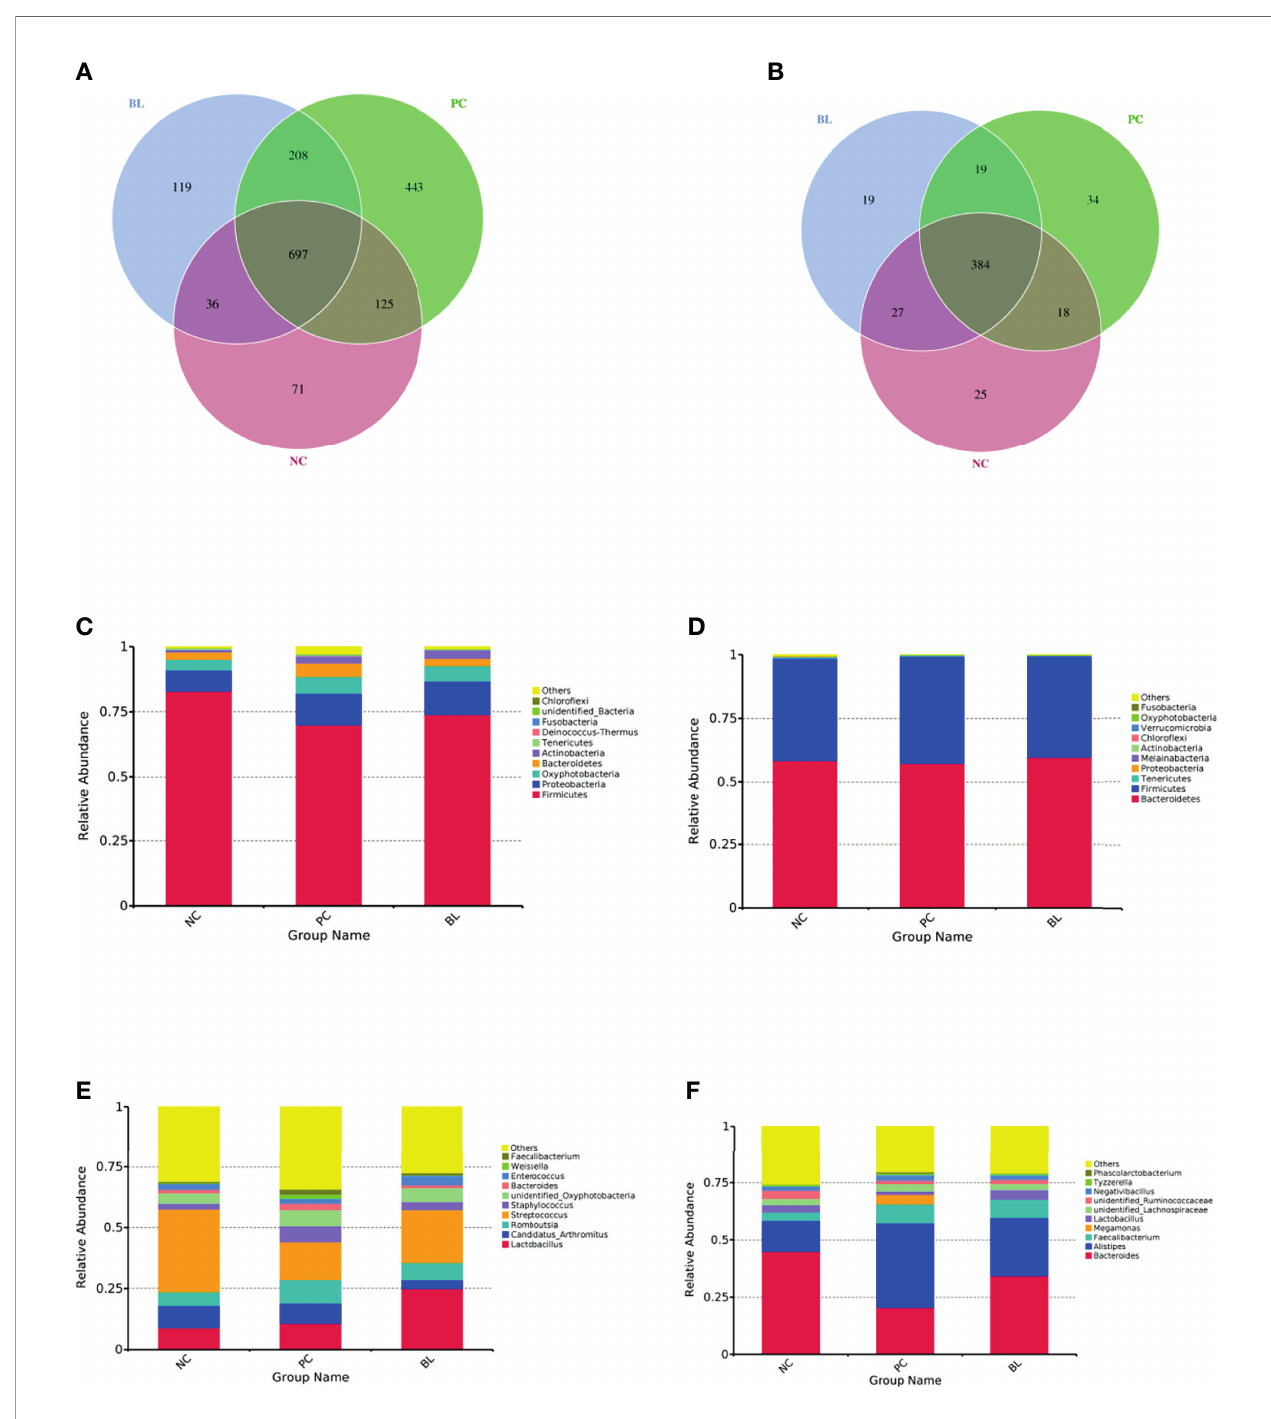
FIGURE 9 | Venn diagrams for OTU and bacterial taxonomic compositions at the levels of phylum and genus in the ileum (A, C, E) and the cecum (B, D, F)